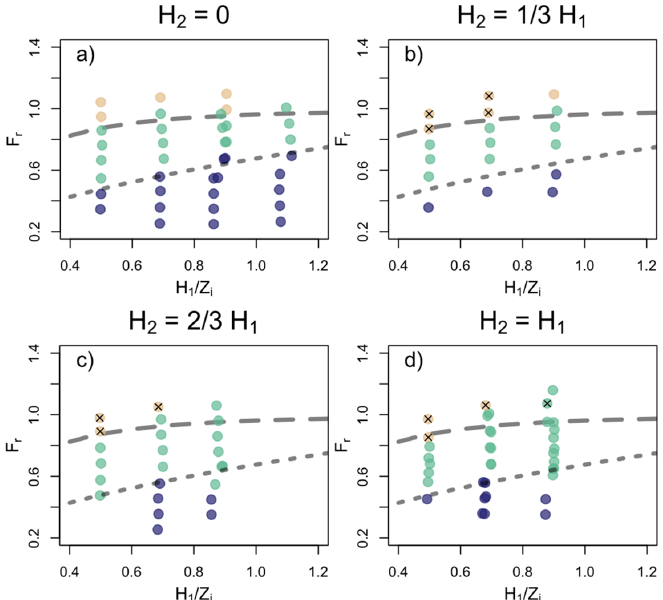
Figure 6. Regime diagram of HyIV-CNRS-SecORo experiments showing the dependence of flow type on Froude number Fr and dimensionless inversion height ( H 1 /Z i ) for the: ( a ) single obstacle runs; ( b ) runs where the secondary obstacle is one-third of the height of the first one; ( c ) the secondary obstacle is two-thirds of the height of the first one; and ( d ) for obstacles of equal height. The long-dashed